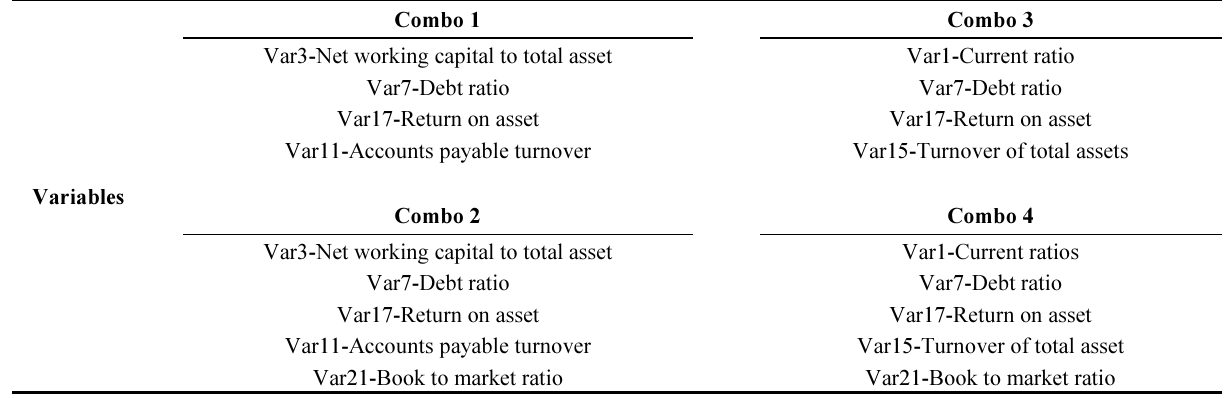
Table 5. The combinations of models in the multivariate logit analysis